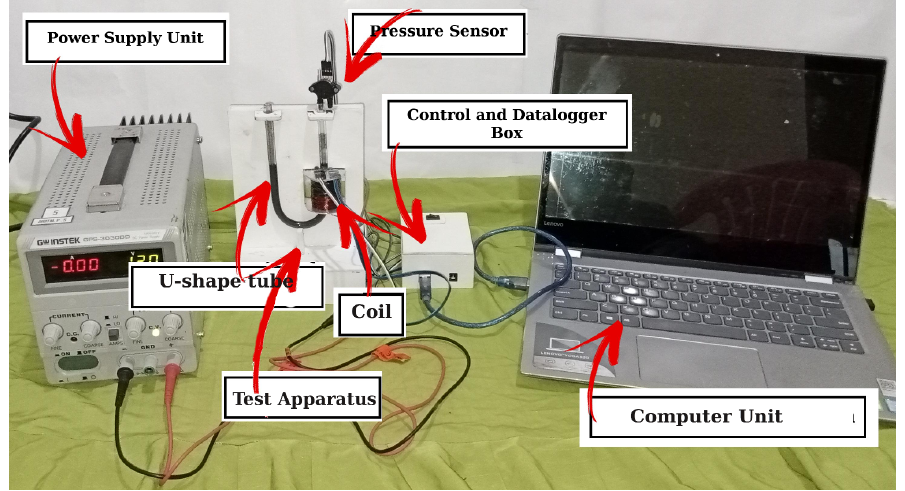
Figure 5. The research apparatus.